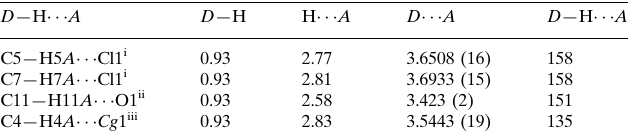
Hydrogen-bond geometry (A˚ , (cid:1)